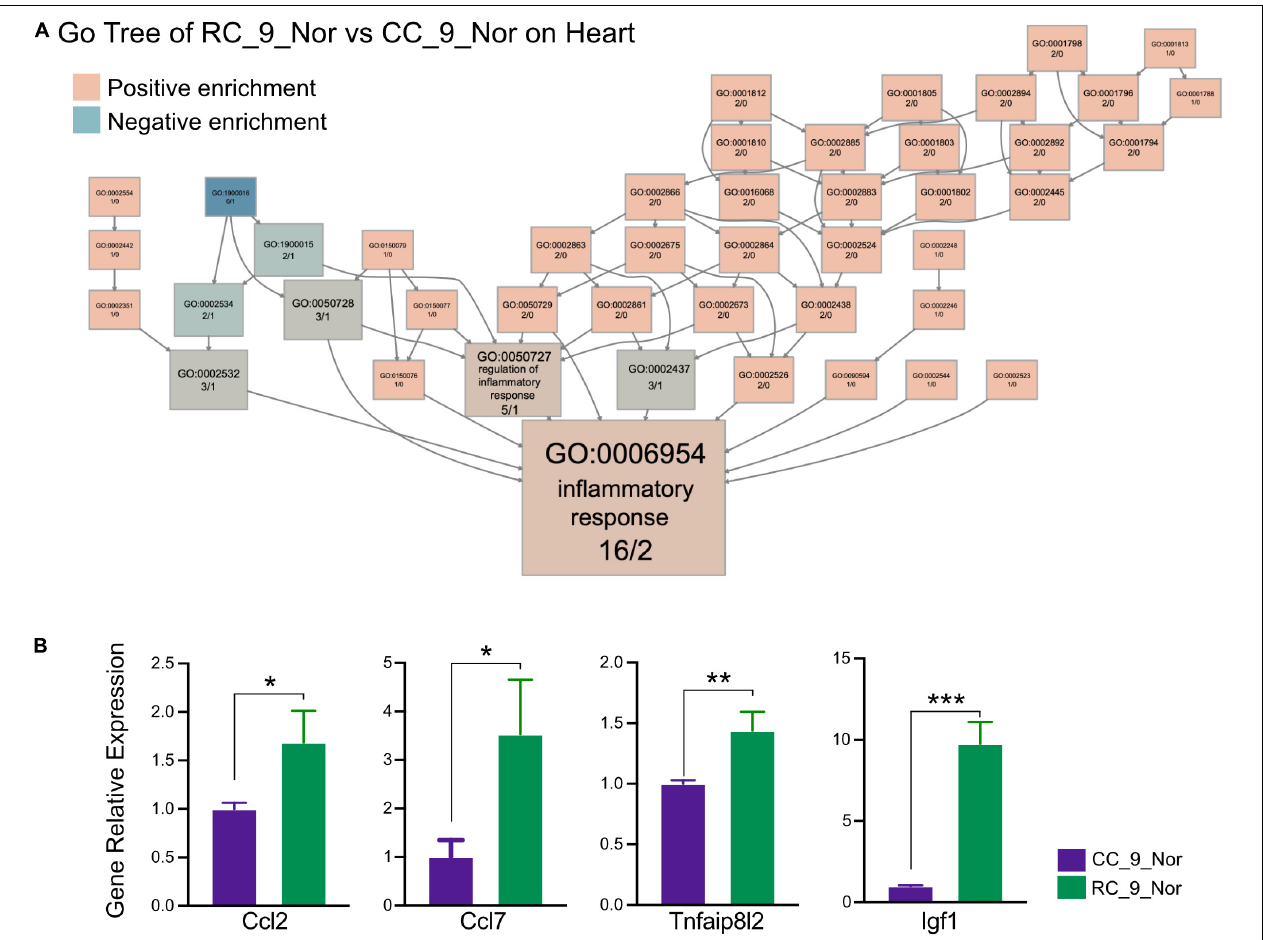
FIGURE 3 | IUGR activates chronic inflammation in the heart. (A) The GO tree of RC_9_Nor vs. CC_9_Nor on the cardiac muscle. The box numbers represented the relative amount of DEG in the category. The box color equated to the numbers of upregulated and downregulated DEGs, with upregulated represented by pink and downregulated equaling blue, which indicated chronic inflammation activity existing in the heart due to IUGR. (B) The verification of important genes in GO:0006954 between these two groups by qPCR. * p < 0.05, ** p < 0.01, *** p < 0.001.